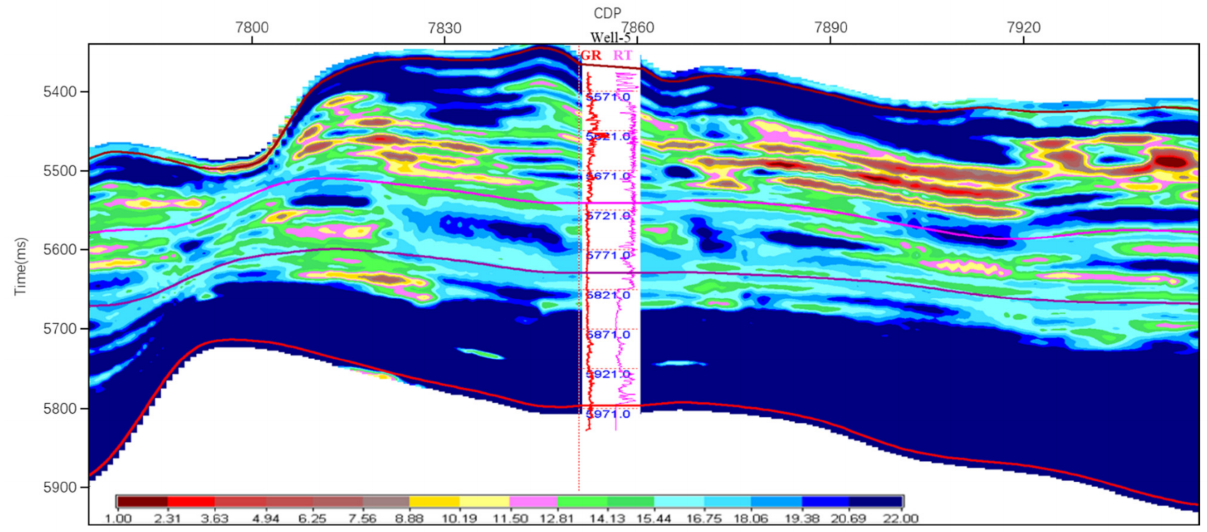
Figure 7. Profile of the Lame coefficient inversion result. Note that Well 5 is the well that was not involved in the